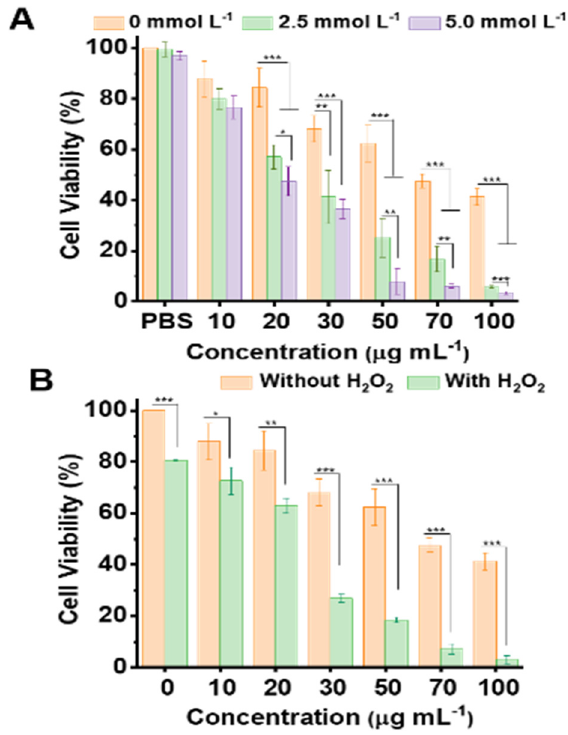
Figure 6. ( A ) The dependence of MCF-7 cell viability on the concentration of GSH (0, 2.5 and 5.0 mmol L –1 ) by incubation with Cu-MOF at the levels of 10, 20, 30, 50, 70, 100 μ g mL –1 . ( B ) The MCF- 7 cell viability on H 2 O 2 (100 μ mol L –1 ) by incubation with Cu-MOF at the levels of 10, 20, 30, 50, 70, 100 μ g mL –1 . Values of p < 0.05 were considered statistically significant, with *, **, *** represent p < 0.05, p < 0.01, and p < 0.001,